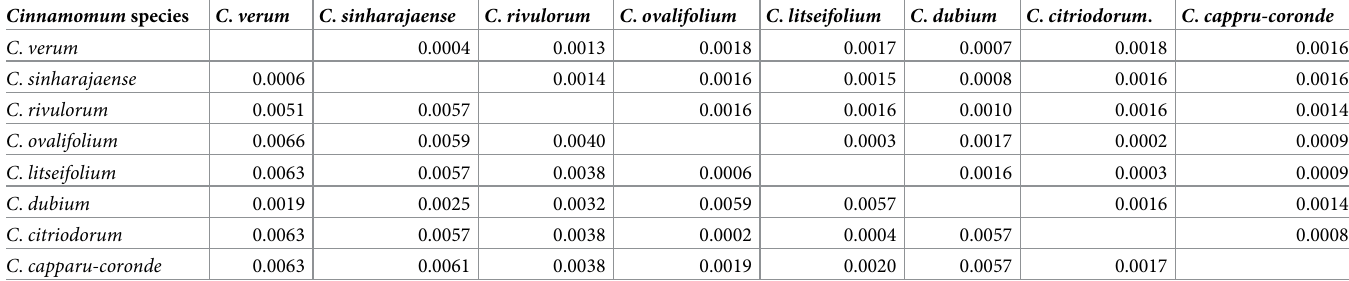
Table 5. Interspecific sequence divergence between